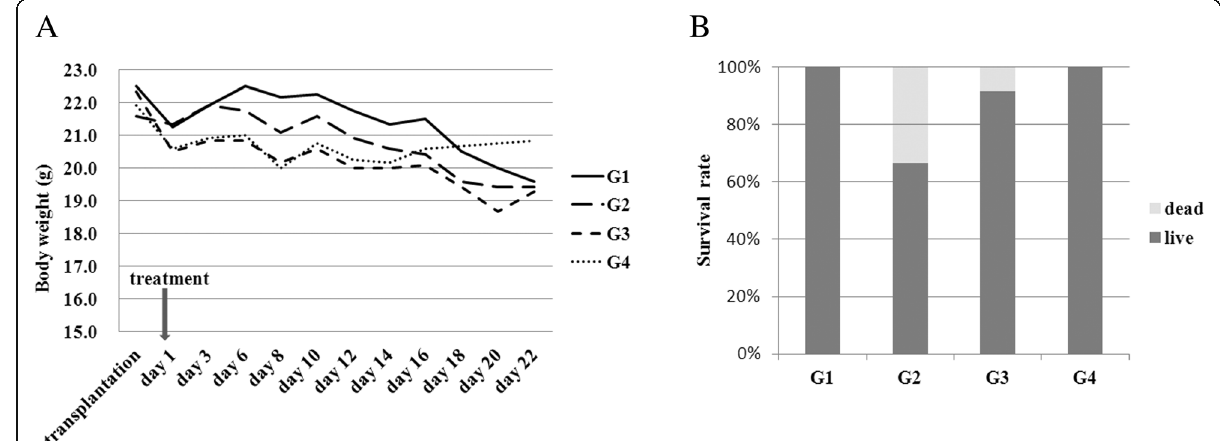
Fig. 1 Changes of mice body weights and survival rates after 3 weeks of modified SJZ treatment. a Changes of mice body weights after treatments. G1:Control group (normal saline, intragastric administration twice a day for 3 weeks); G2:5-Fu group (15 mg/kg, intraperitoneal injection twice a week for 3 weeks); G3: MSJZ group (45 g/kg, intragastric administration twice a day for 3 weeks); G4: Combined (15 mg/kg 5-Fu, intraperitoneal injection twice a week and 45 g/kg MSJZ, intragastric administration twice a day for 3 weeks). Data are expressed as mean. b Changes of survival rates in different groups. 5-Fu: 5- fluorouracil; MSJZ: modified Si-Jun-Zi